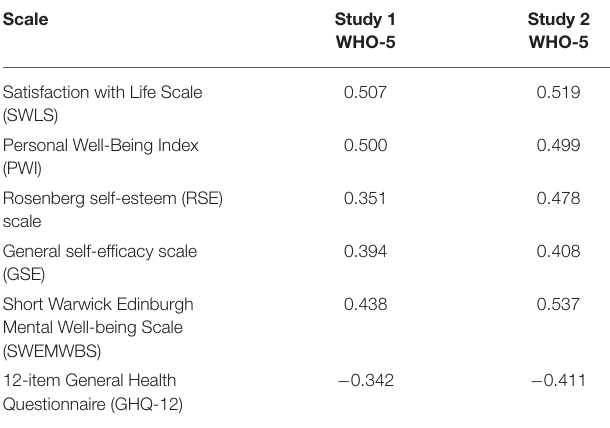
TABLE 4 | Correlations between the WHO-5 in relation to other well-established